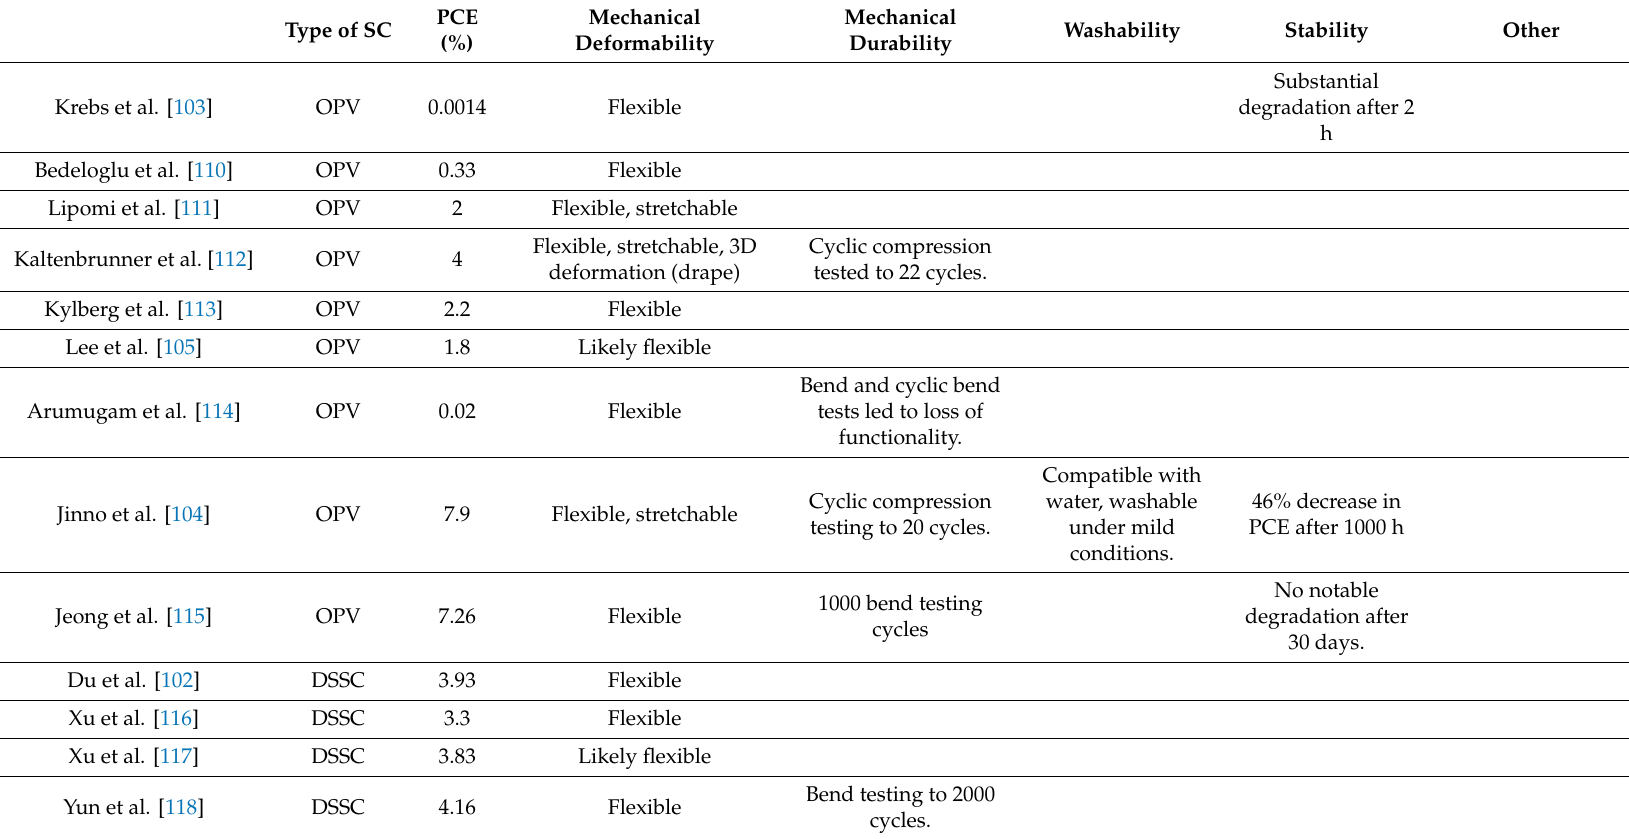
Table 1. Summary of key information regarding the reported properites of various photovoltatic films and coatings used on textiles. Please note that PCE (%) are the values given and do not account for any di ff erences in how the PCE may have been calculated between works. ‘Likely flexible’ has been stated when the flexability of the device is not explictily commented upon or